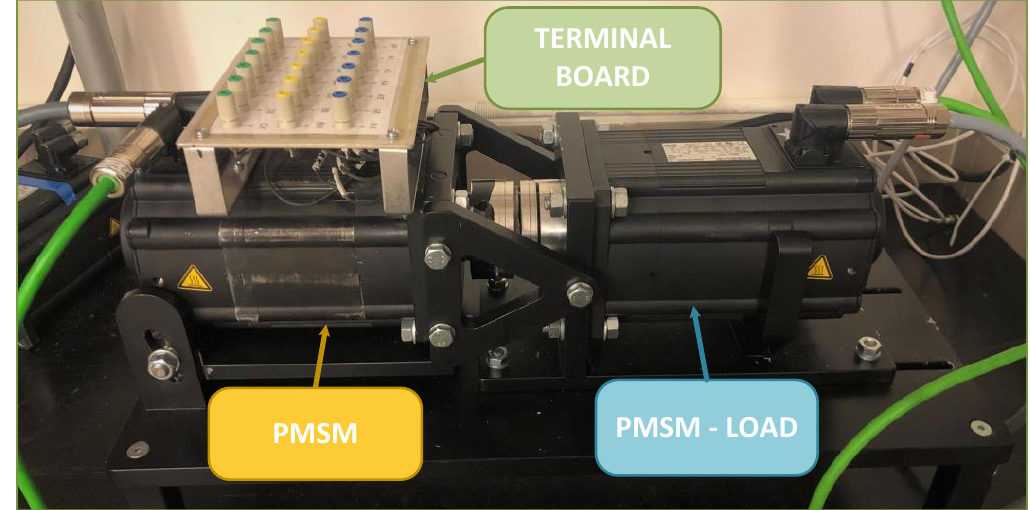
Figure 6. Specially designed laboratory stand.